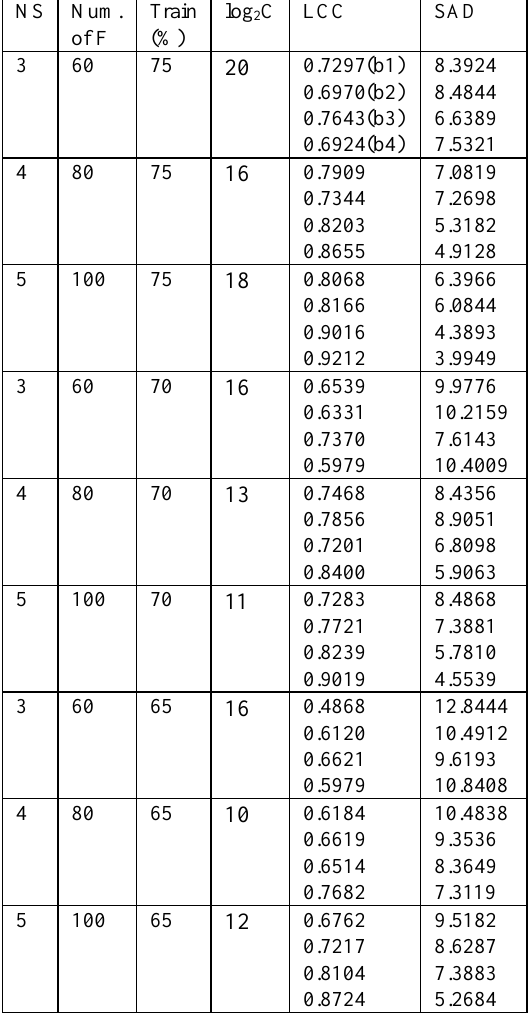
Table 2. LCC and SAD results for different test setup Table 2 shows the results of LCC and SAD for different test setup. 'NS' is the scale numbers for multi scale